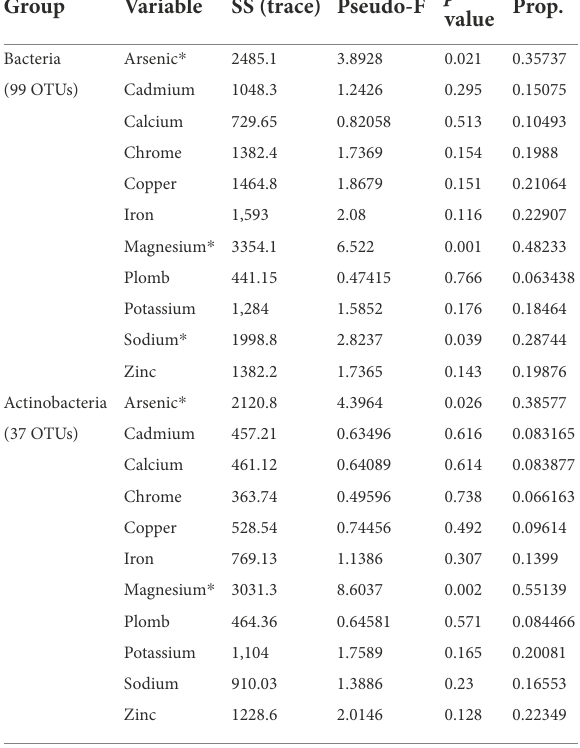
TABLE 2 Correlation between physicochemical factors and the structure of bacterial and Actinobacteria communities associated with stones according to the Distance-based Linear Model (DistLM) marginal test that considers every single element and their contribution to explain the total